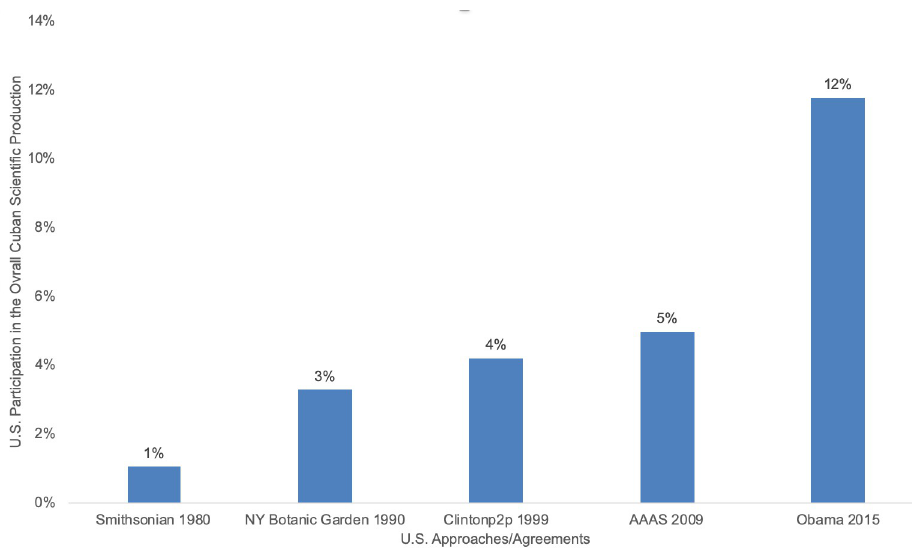
Fig 1. The percent of the U.S. scientist’s participation in overall Cuban scientific production. The stages are organized according to U.S. main scientific approaches/agreements. The time-line from the year of the agreement through the next significant milestone. These milestones were selected according to the documents on U.S.-Cuban scientific collaboration. Source: Clarivate Analytics Web of Science, and Scopus.